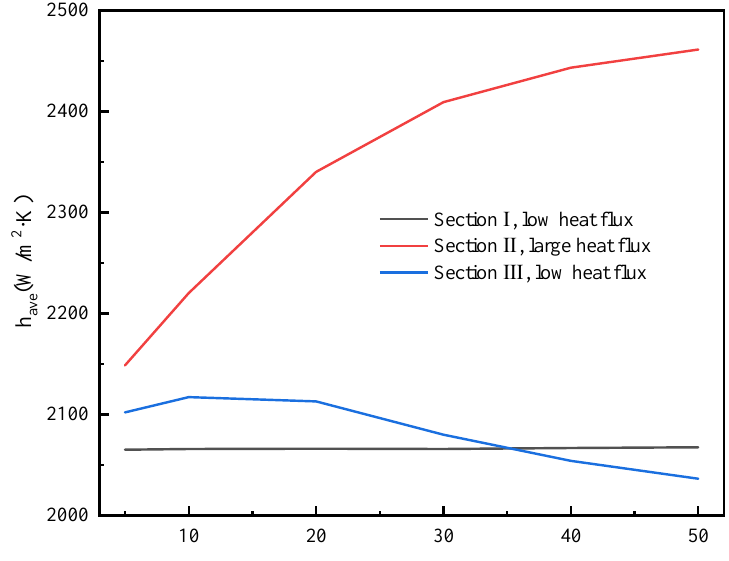
Figure 14. The average heat transfer coefficient for each section at different multiples of local large heat